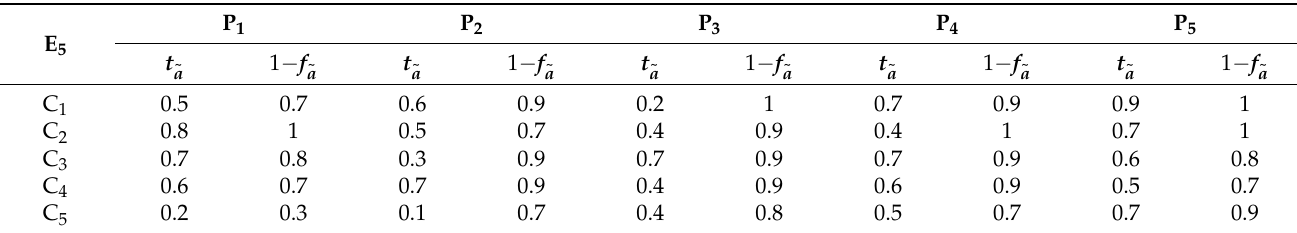
Table 18. Expert 5’s assessments on the different patients’